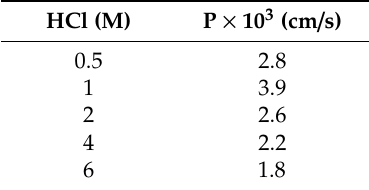
Table 3. Gold(III) permeabilities at various HCl concentrations in the feed phase.